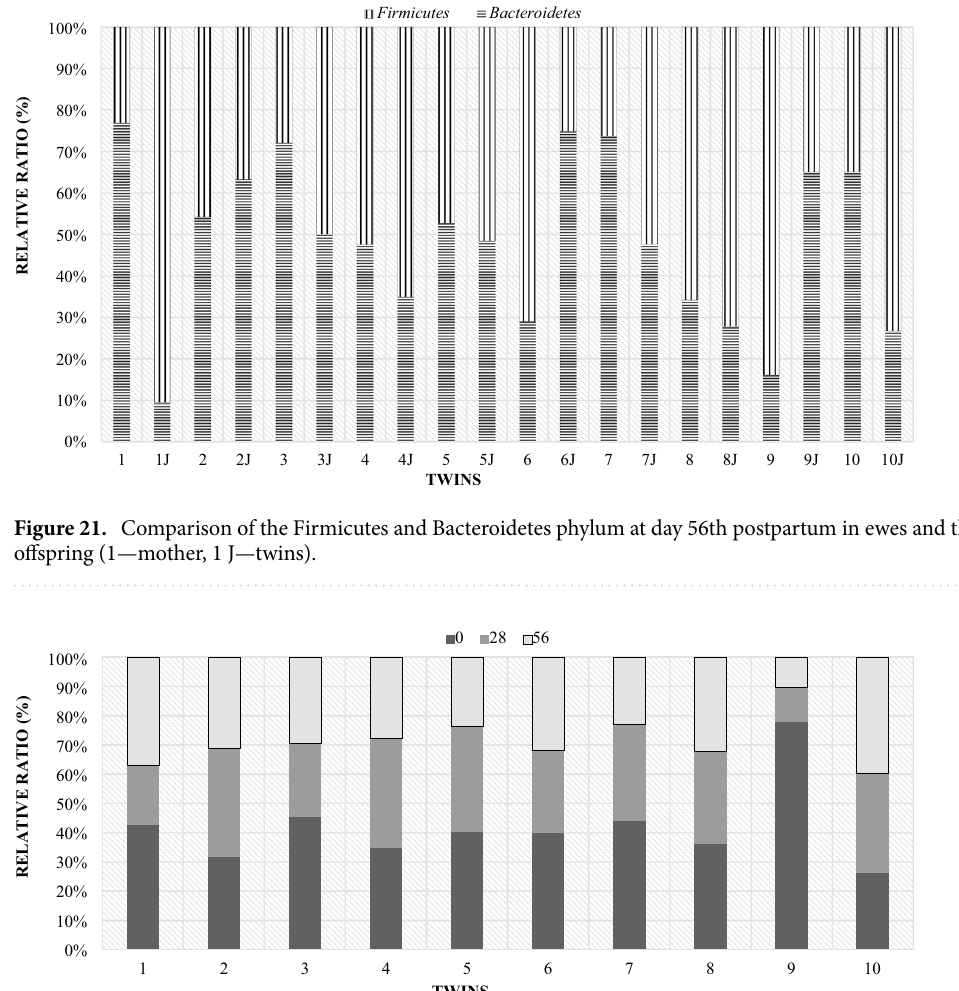
Figure 22. Relative ratio (%) of the Lactobacillaceae family in individual pairs of twins depending on the days.